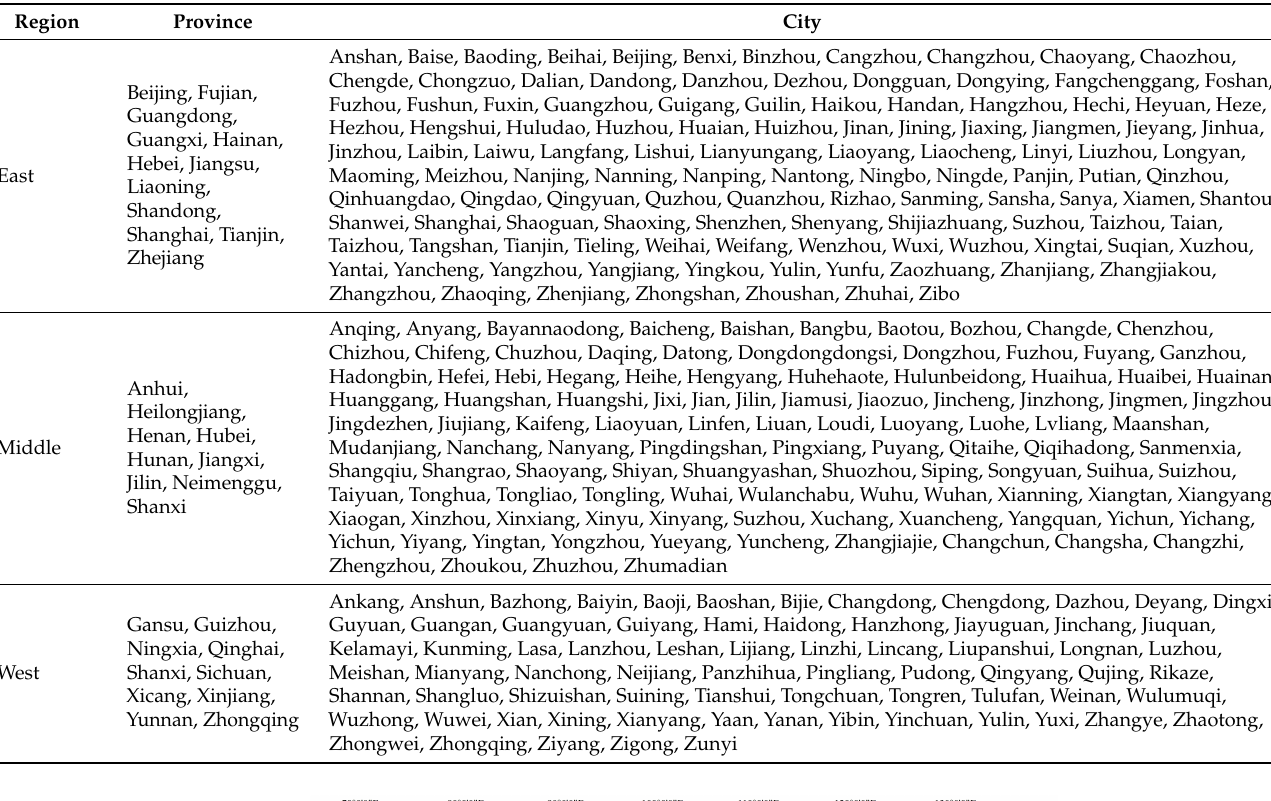
Table A1. Regional division of Chinese provinces, as shown in The 7th Five-Year Plan in China and Zhang [44]. The division is also shown in Figure 1.